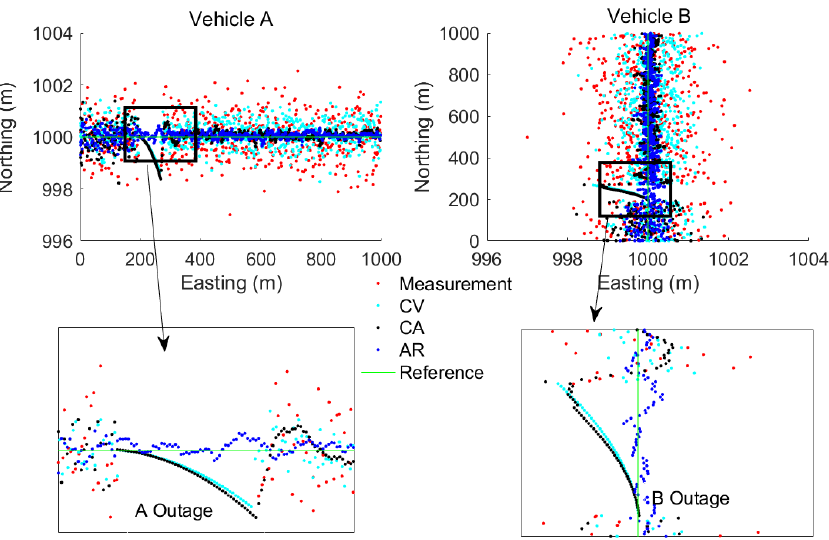
Figure 5. An example of fusion model estimated results for TC2 with intersection perpendicular collision type.